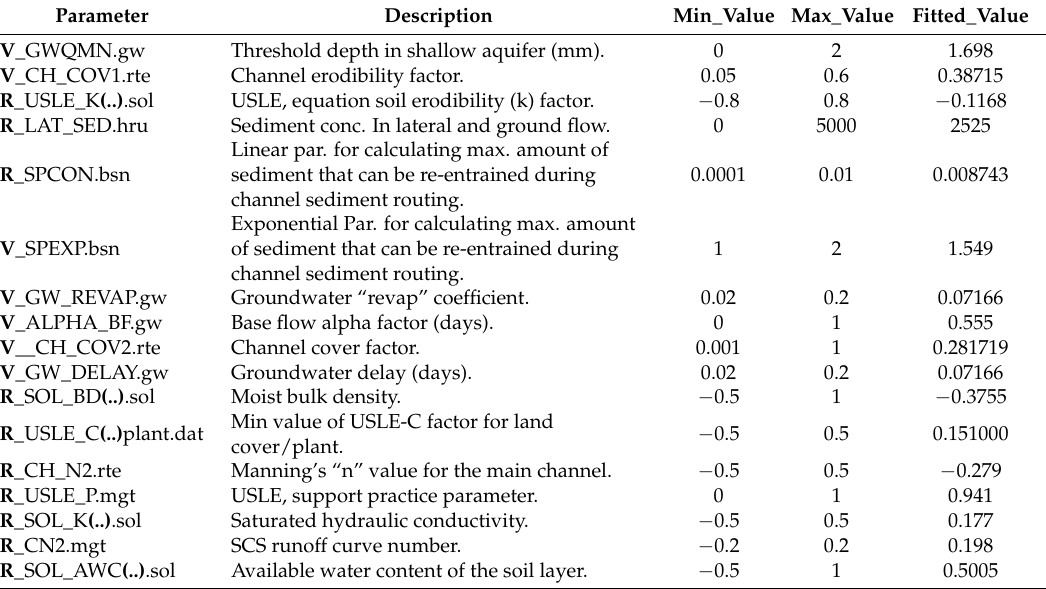
Table 3. The range, optimal (fitted) values and sensitivity analysis of considered parameters.